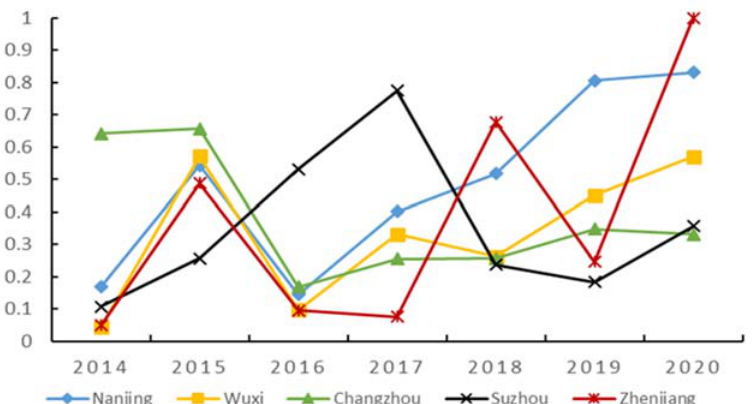
Figure 6. The order degrees of open cooperation subsystems of Taihu Basin among cities during 2014–2020.